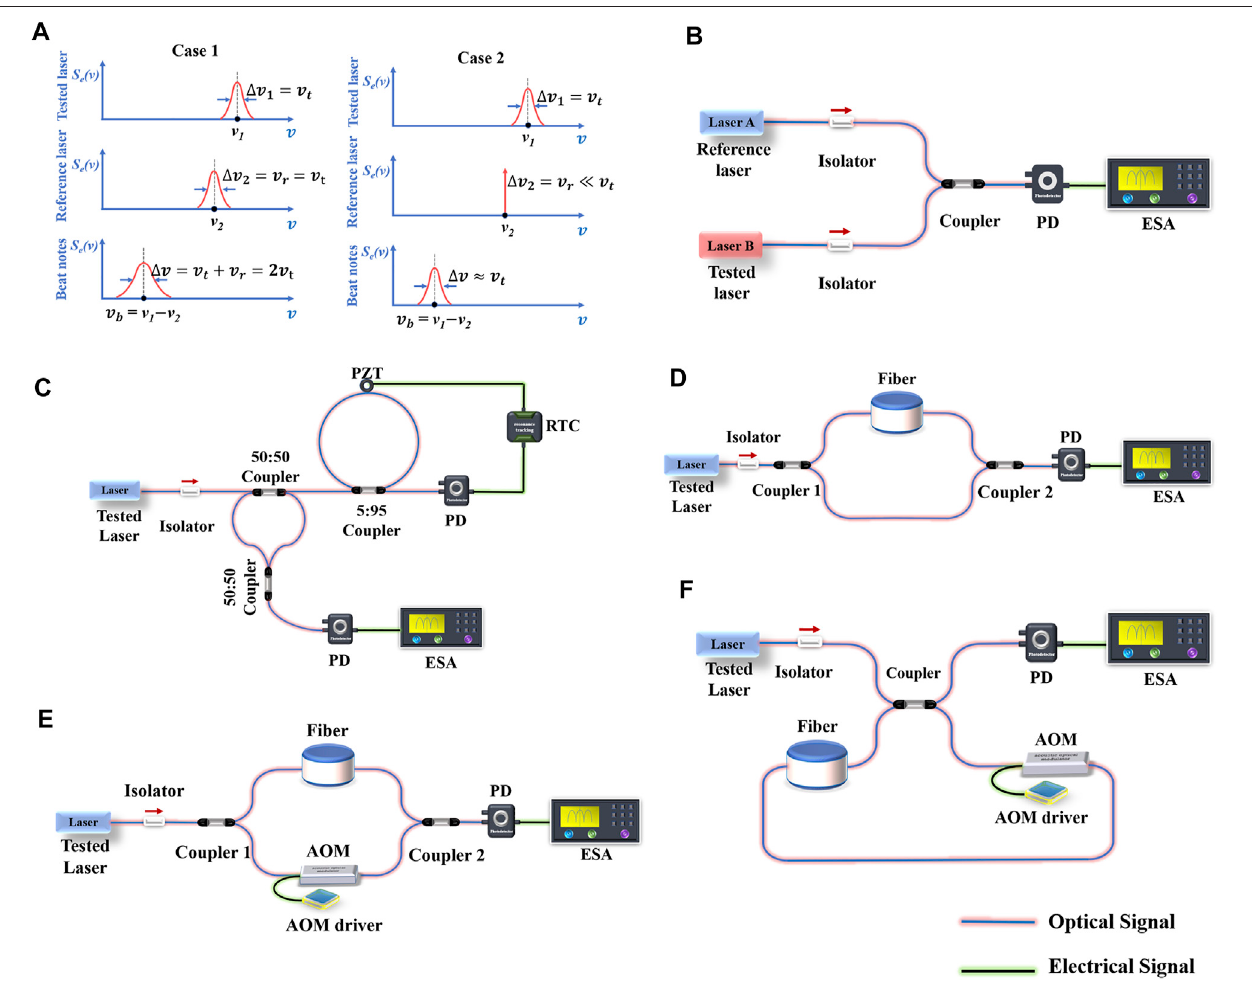
FIGURE 1 | (A) Principle of optical beat notes, (B) beating note with a reference laser, (C) beating note with the Stokes wave of a Brillouin laser, (D) delayed self- homodyne interferometric detection, (E) delayed self-heterodyne interferometric detection, and (F) recirculating delayed self-heterodyne interferometer detection (PD, photodetector; ESA, electrical spectrum analyzer; RTC, resonance tracking circuit; PZT, piezoelectric transducer; AOM, acoustic optical modulator).